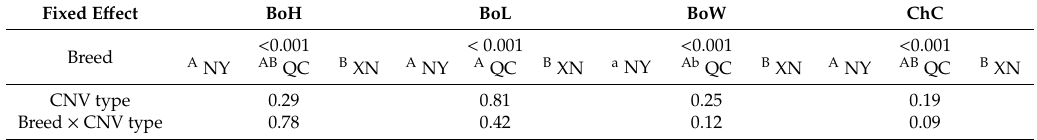
Table 4. p -Value results of two-way ANOVA for four phenotypes of NY, QC and XN